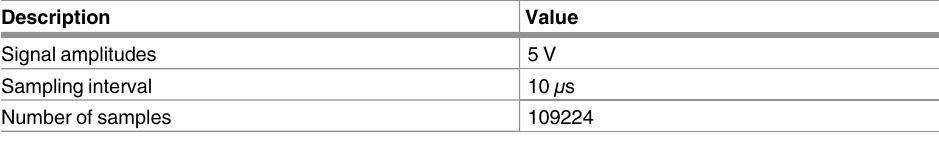
Table 2. Measurement parameters of the